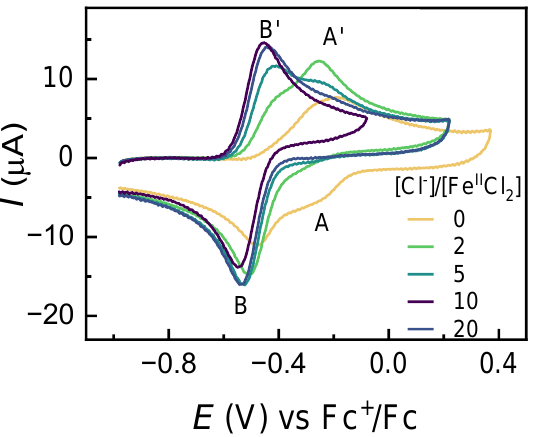
Figure 3. Cyclic voltammetry of 1 mM FeCl 2 in DMF + 0.1 M Et 4 NBF 4 recorded on a GC electrode at v = 0.2 V/s and T = 25 °C, before and after addition of different amounts of Et 4 NCl.